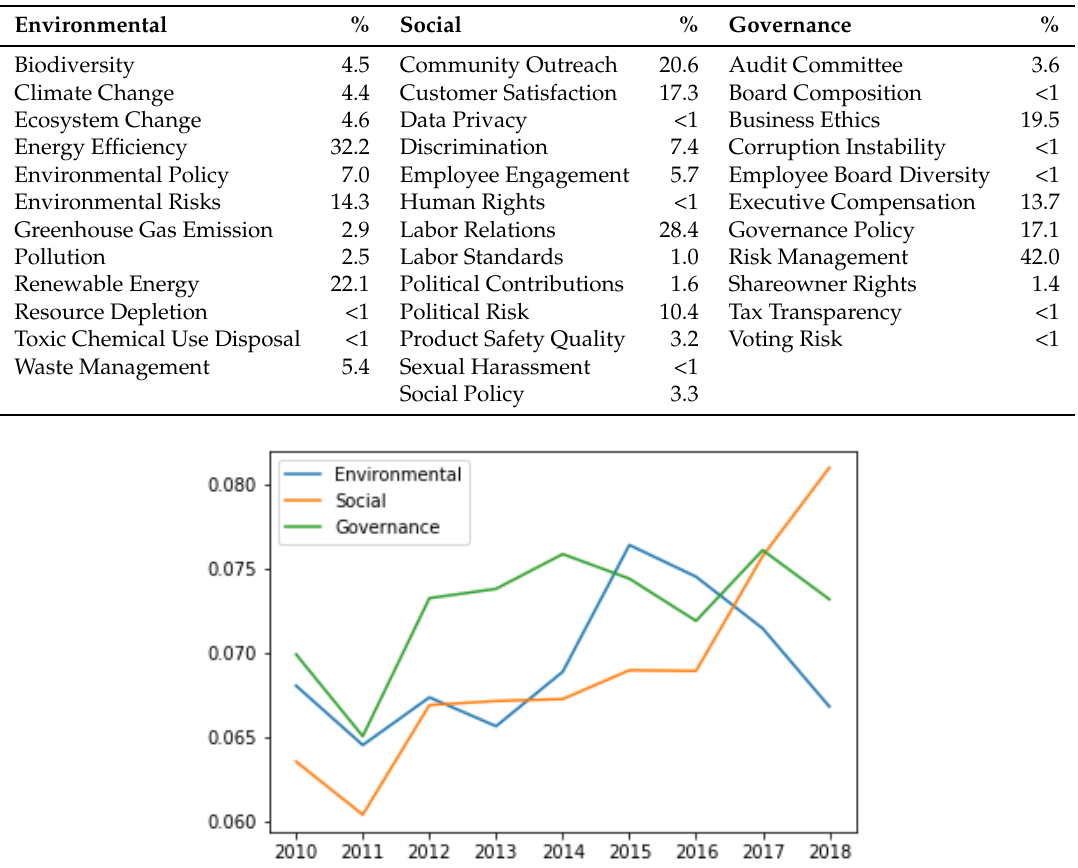
Table 5. ESG factors and their distribution in the earnings call transcript dataset.